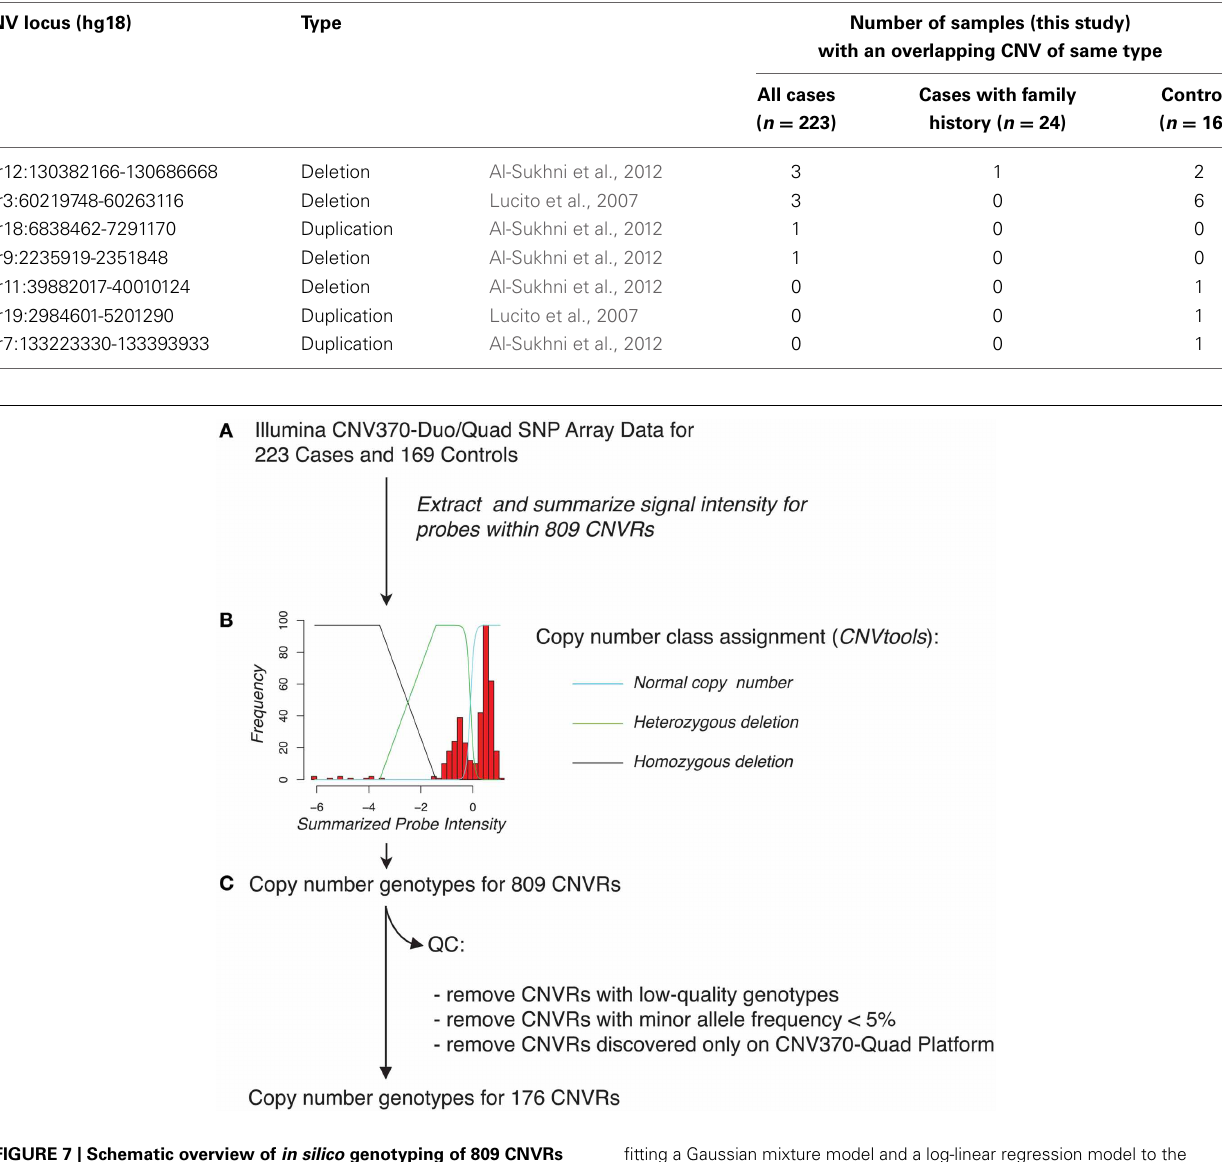
fitting a Gaussian mixture model and a log-linear regression model to the observed distribution of summarized probe intensities. An example fit is shown, overlaid with the estimated locations of individuals who have normal copy number class, a heterozygous deletion, or a homozygous deletion (blue, green, and black lines, respectively) for this CNVR. (C) Quality-control was applied by removing CNVRs with low-quality genotyping, low minor allele frequency, or CNVRs that were derived solely from samples genotyped on the Illumina CNV370-quad